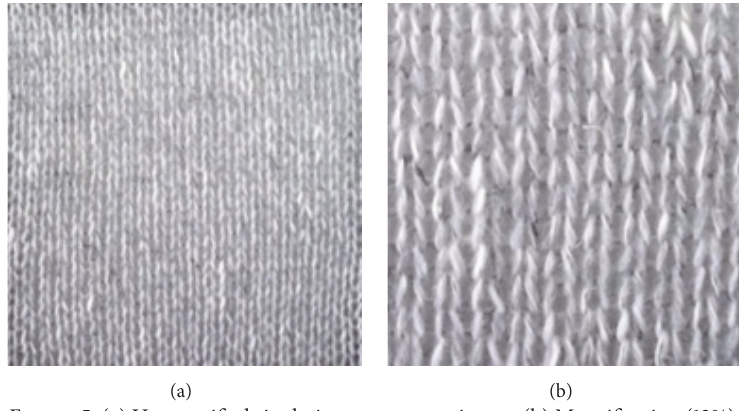
Figure 5: (a) Unmagnified single-jersey structure image. (b) Magnification (12%). Table 4: Fabric features knitted for testing and validation and percentage of error for the porosity against stitch length of white and black mask images (FKM samples).